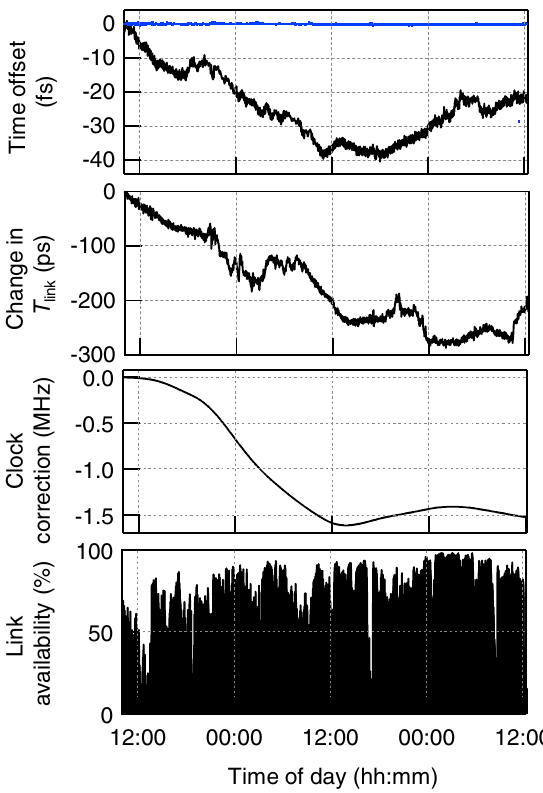
FIG. 4. Synchronization data across 4-km air path over a 50-h time period including, from top to bottom, the measured time offsets for both the out-of-loop Δ T (black trace) and the in-loop Δ T (blue trace), the change in time of flight T , the frequency AB link correction applied to the time scale at site B to maintain synchronization, and the link availability. All data are filtered and down-sampled from the 0.5-ms measurement period to 60